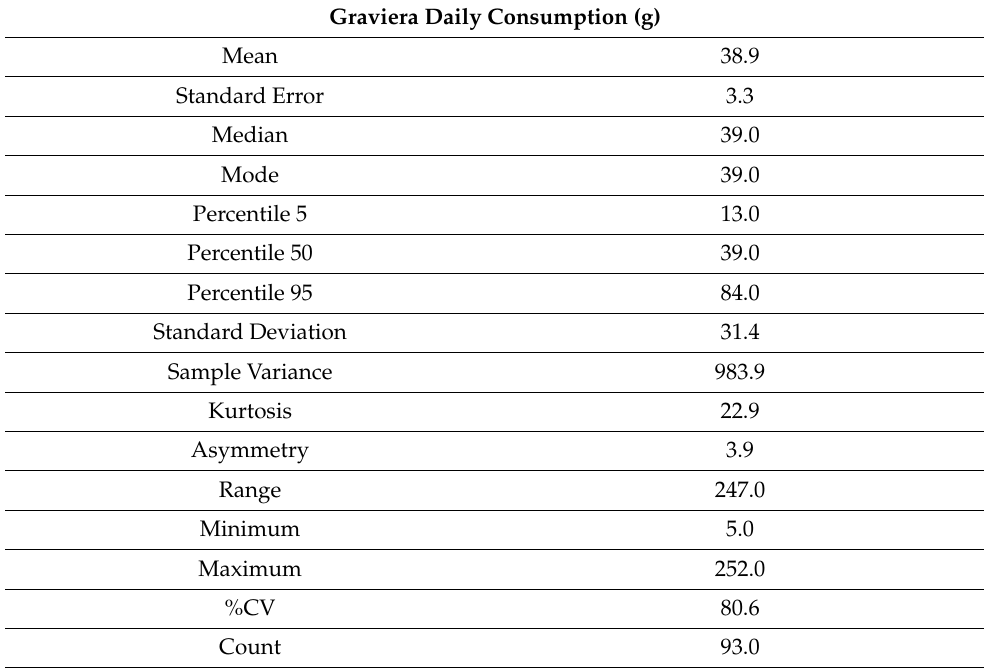
Table 3. Descriptive Statistics of graviera cheese consumption data for adults 20–65 years old according to the Hellenic National Nutrition and Health Survey